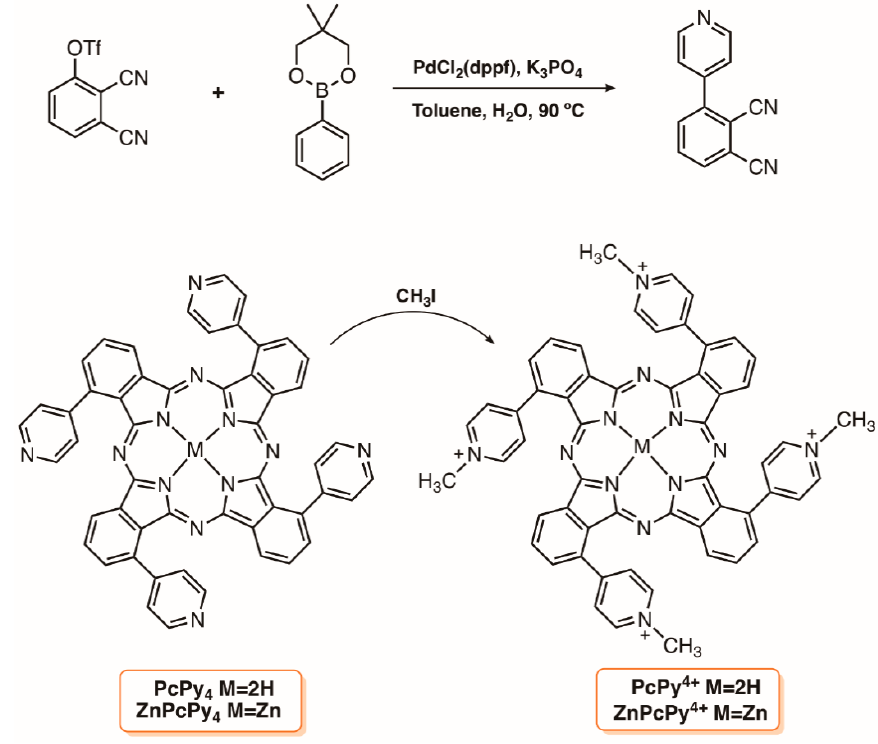
Figure 22. Synthetic access to the phthalonitrile used in the preparation of phthalocyanines (Zn)PcPy 4 and (Zn)PcPy 4+ (adapted from Reference [126]).